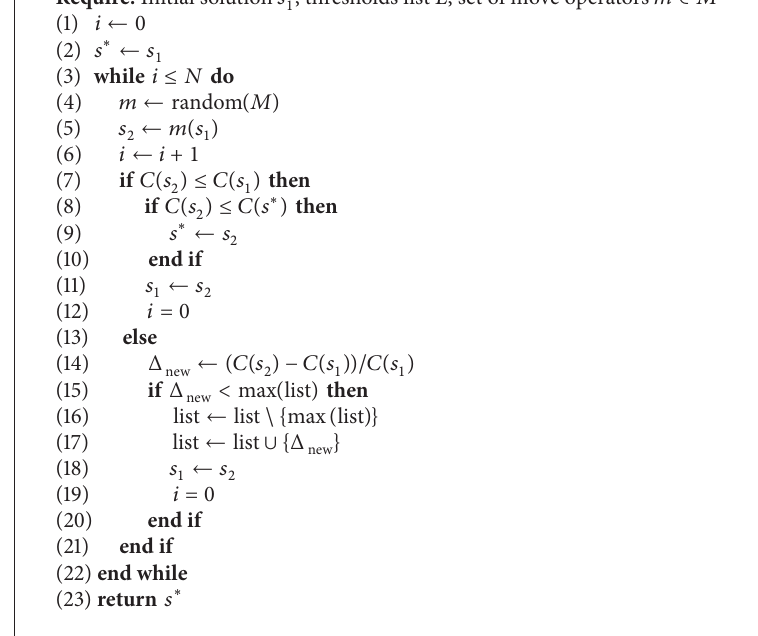
Algorithm 2: LBTA optimization procedure.